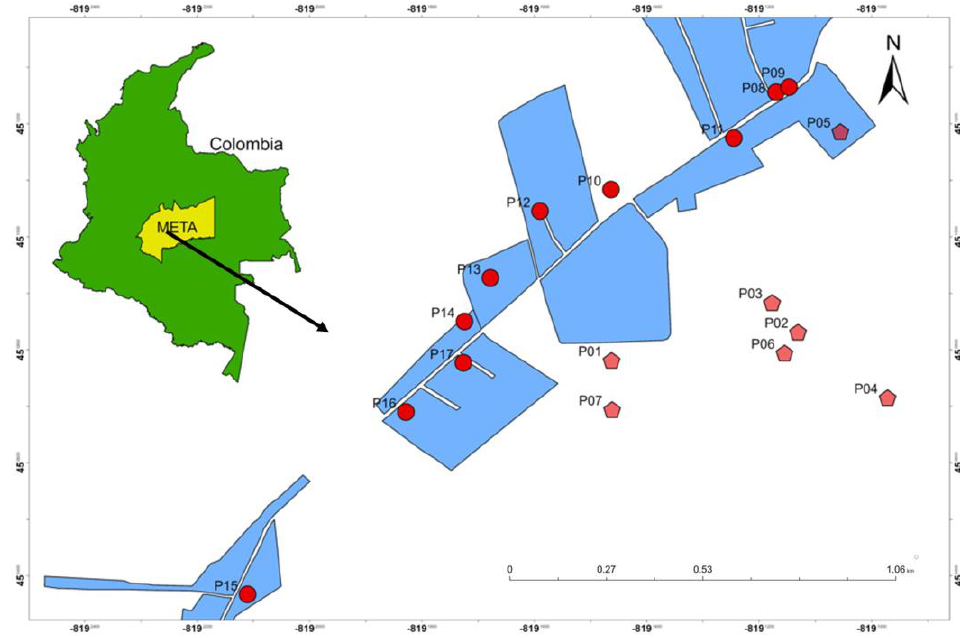
Figure 1. Location of the studied rural settlement (Villavicencio) in